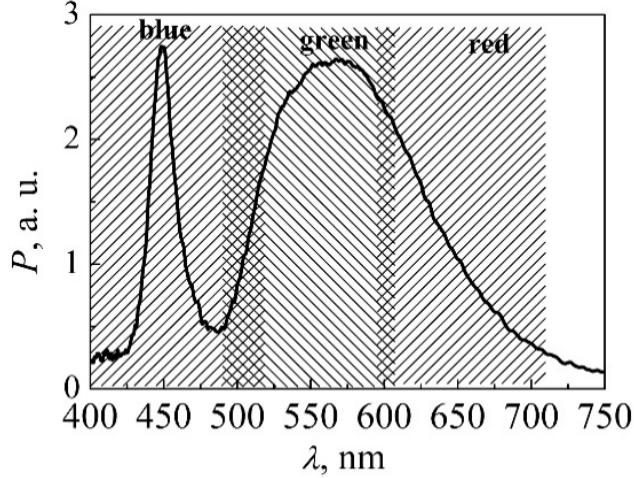
Figure 4. Ranges of spectral response (dashed areas) of each photodetector of the photodiode matrix S9702 and the light spectrum of white LED at 300 mA current (solid line). © 2011 IEEE. Reprinted with permission from [28].